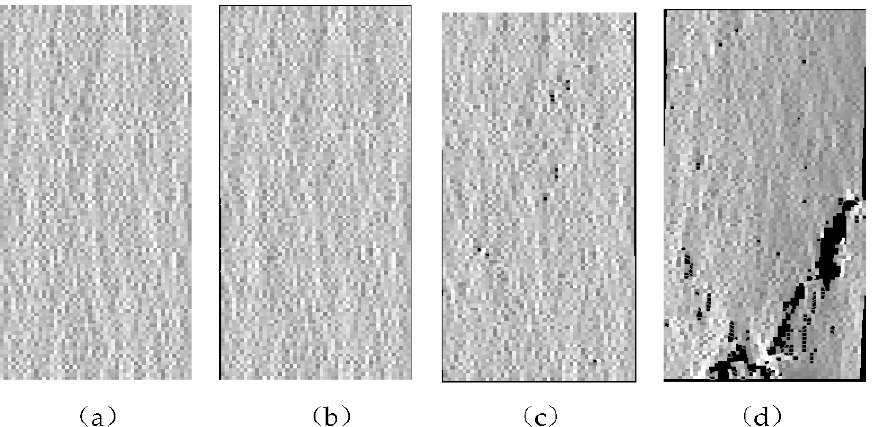
Figure 8. Deformation and rupture of coal samples when the gas pressure is 0 MPa: ( a ) the loading step is 15; ( b ) the loading step is 35; ( c ) the loading step is 50; ( d ) the loading step is 68. (2) Fracture analysis of coal samples when the gas pressure is 0.5 MPa